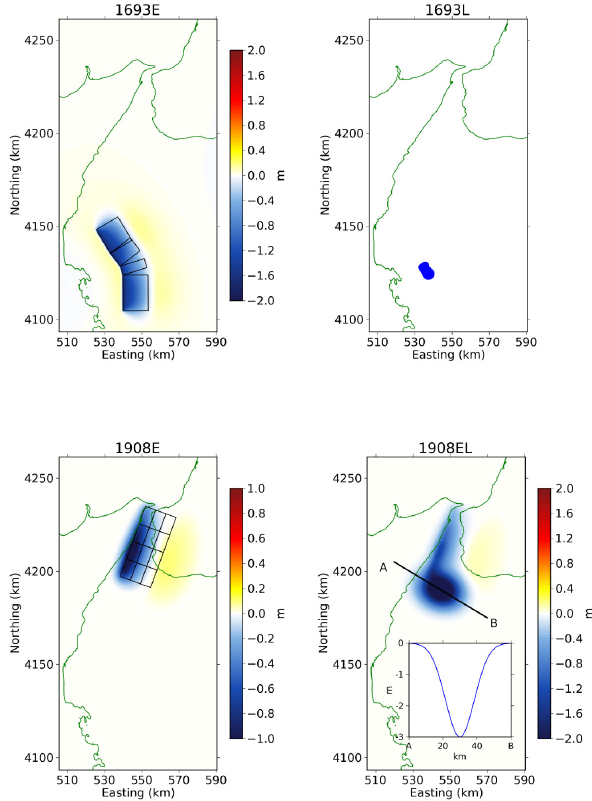
Fig. 3. Initial condition for the source model hypotheses based on the 1693 and 1908 events. For all cases it corresponds to the co- seismic vertical displacement of the sea-floor, except for the 1693 L case where the initial landslide body is